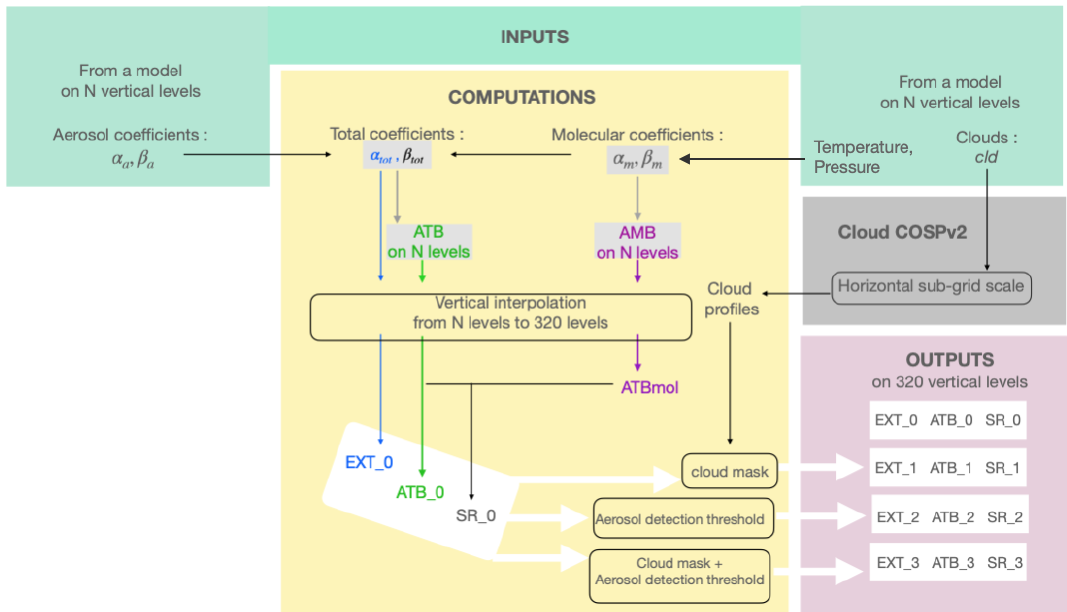
Figure 1. Schematic of the lidar aerosol COSPv2 simulator. See Table 1 for the correspondence between the names of the variables in the code and in the present